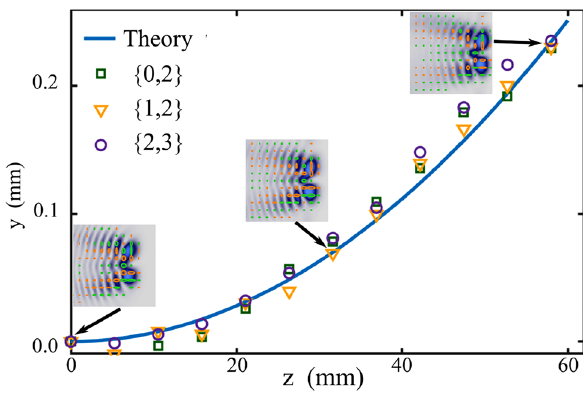
Figure 3: Shift of the y -coordinate of the maximum intensity lobe position for three AVWs upon free-space propagation. The continuous curve represents the expected position predicted by theory, whereas the data points correspond to experiment for the ( 𝜂,𝜉, z ) (squares), AVW cases AVW Figure 2: (a) Example of experimentally measured Stokes 0 , 2 , S , S and S for AVW ( 𝜂,𝜉, z = 0). (b) The ( 𝜂,𝜉, z ) (circles). Notice that all three cases accelerate in an parameters S AVW 0 1 2 3 1 , 2 2 , 3 theoretical and experimental reconstructed intensity and identical way. Insets show the transverse polarisation distribution polarisation distribution from the Stokes parameters for the modes overlapped with the intensity profile of the AVW ( 𝜂,𝜉, 0), AVW ( 𝜂,𝜉, 0), AVW ( 𝜂,𝜉, 0) and AVW ( 𝜂,𝜉, 0). different AVW 0 , 2 1 , 2 1 , 3 2 , 3